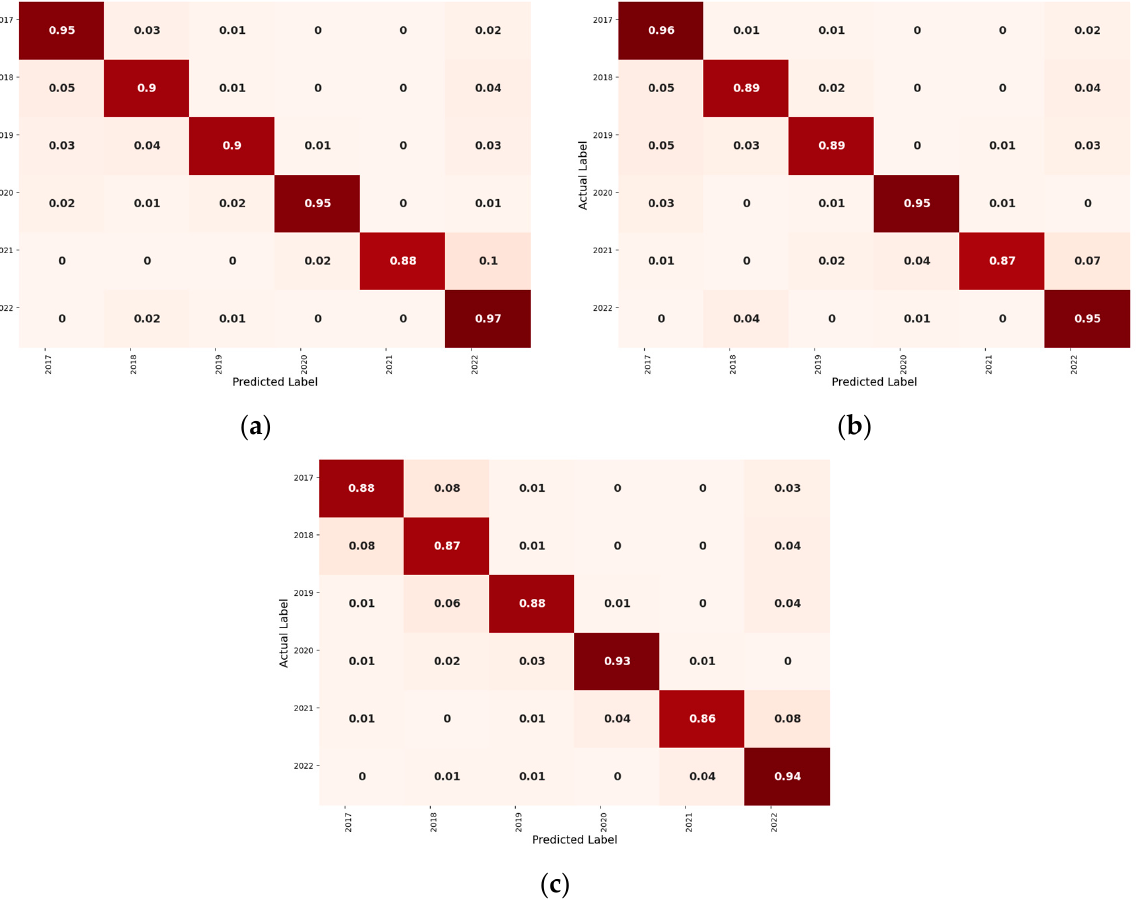
Figure 9. Confusion matrix through ( a ) GRU, ( b ) LSTM, and ( c )